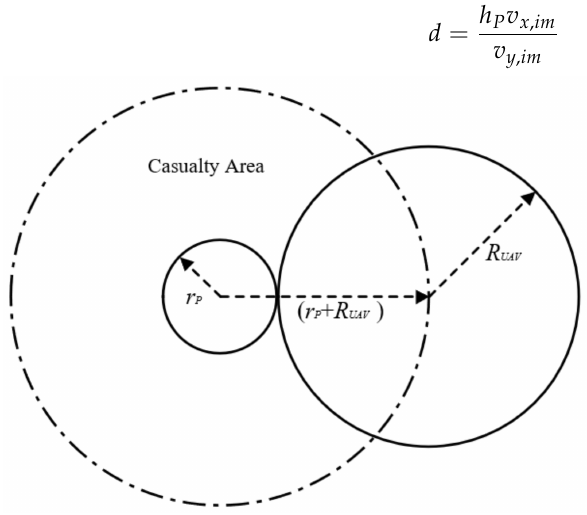
Figure 2. Casualty area caused by vertical impact.